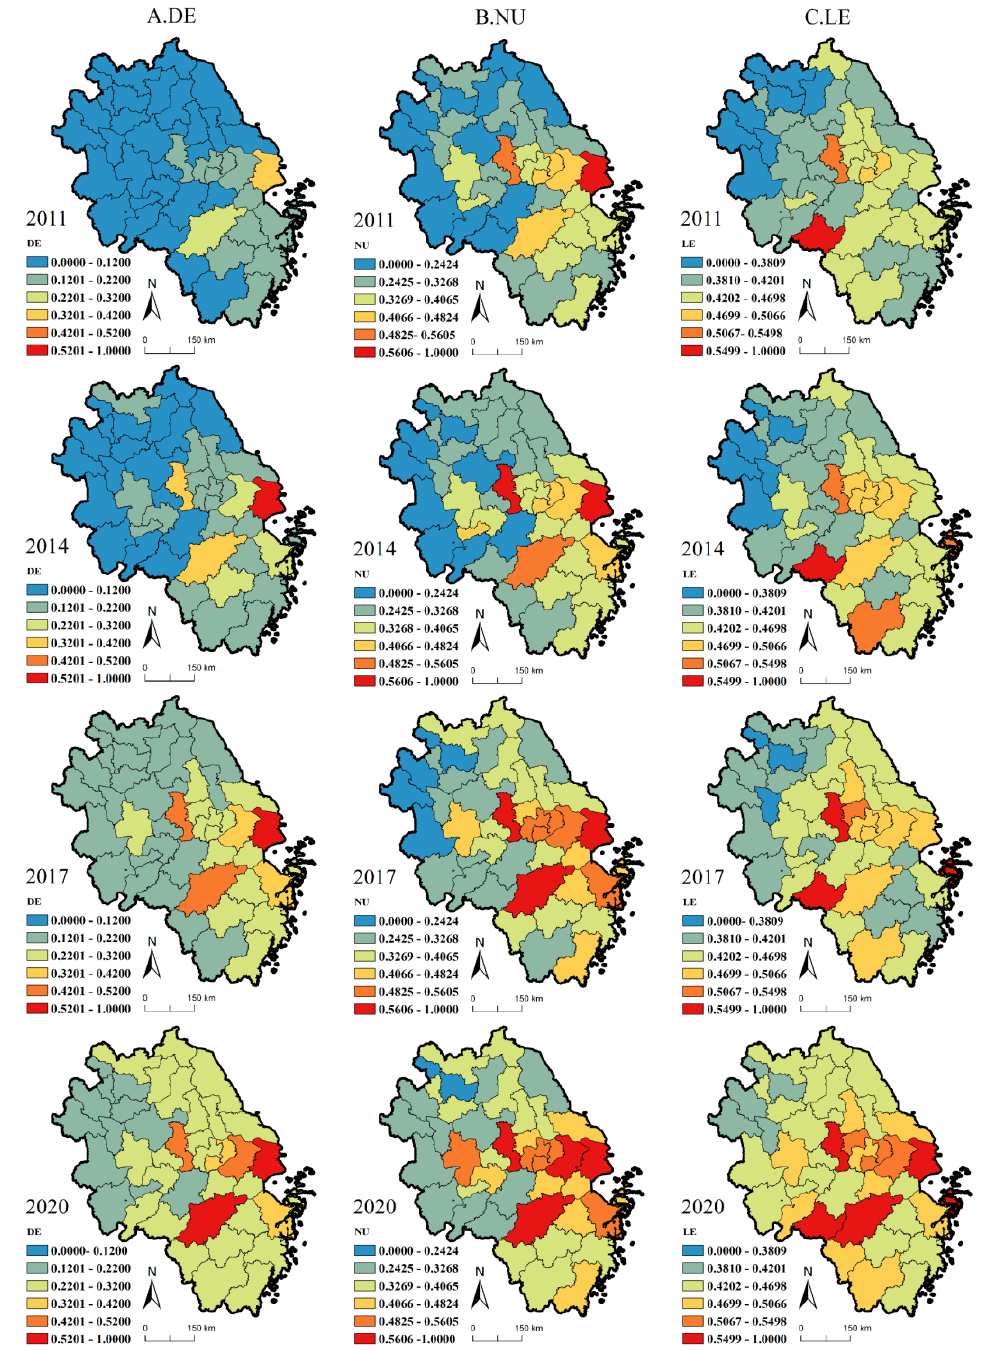
Figure 4. Spatial evolution characteristics of DE–NU–LE. (( A ) presents the four-year changes of DE. ( B ) presents the four-year changes of NU. ( C ) presents the four-year changes of LE.)